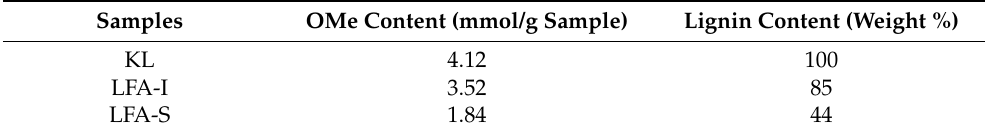
Table 1. The methoxyl content and calculated lignin content in LFA fractions.